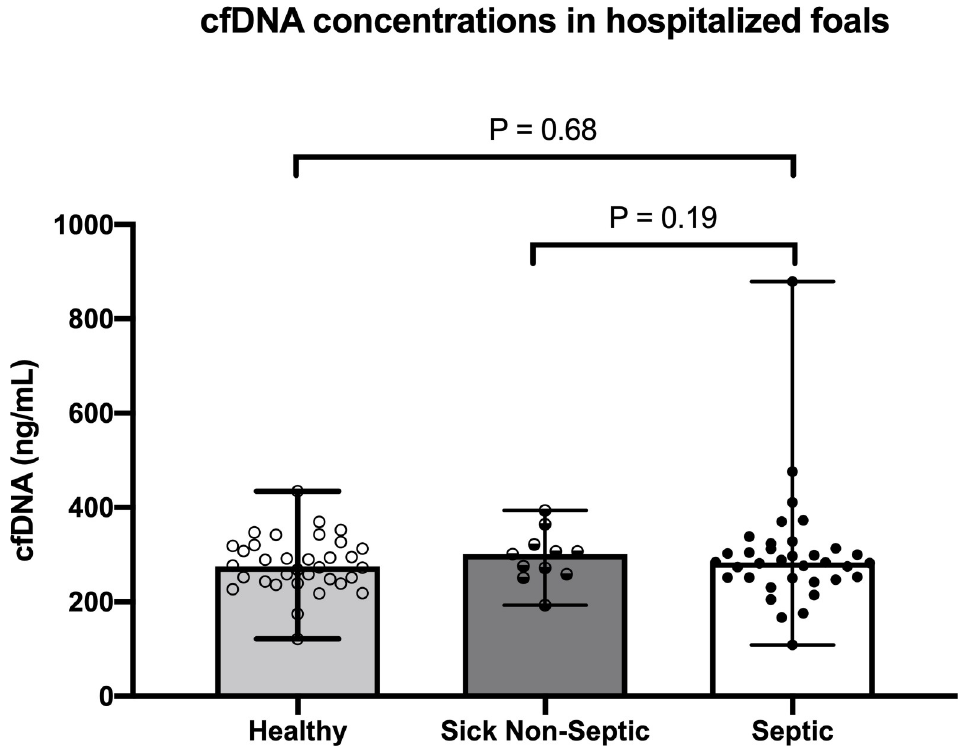
Fig 1. Plasma cell-free DNA (cfDNA) concentrations in healthy foals (n = 34), sick non-septic foals (n = 11) and septic foals (n = 35) based on defined criteria (sepsis score and/or blood culture status). Symbols represent values for individual foals with median and interquartile range error bars (P > 0.05 between groups).